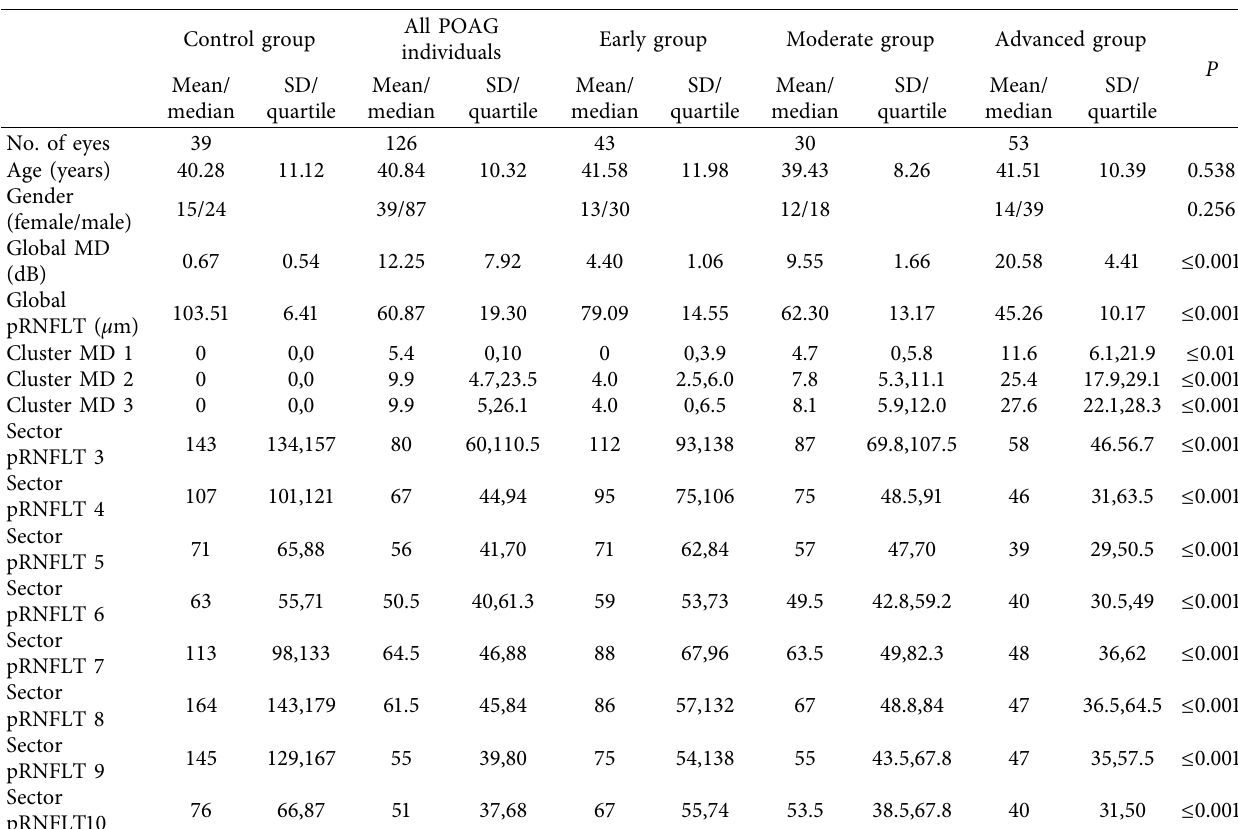
Table 1: Demographics of the